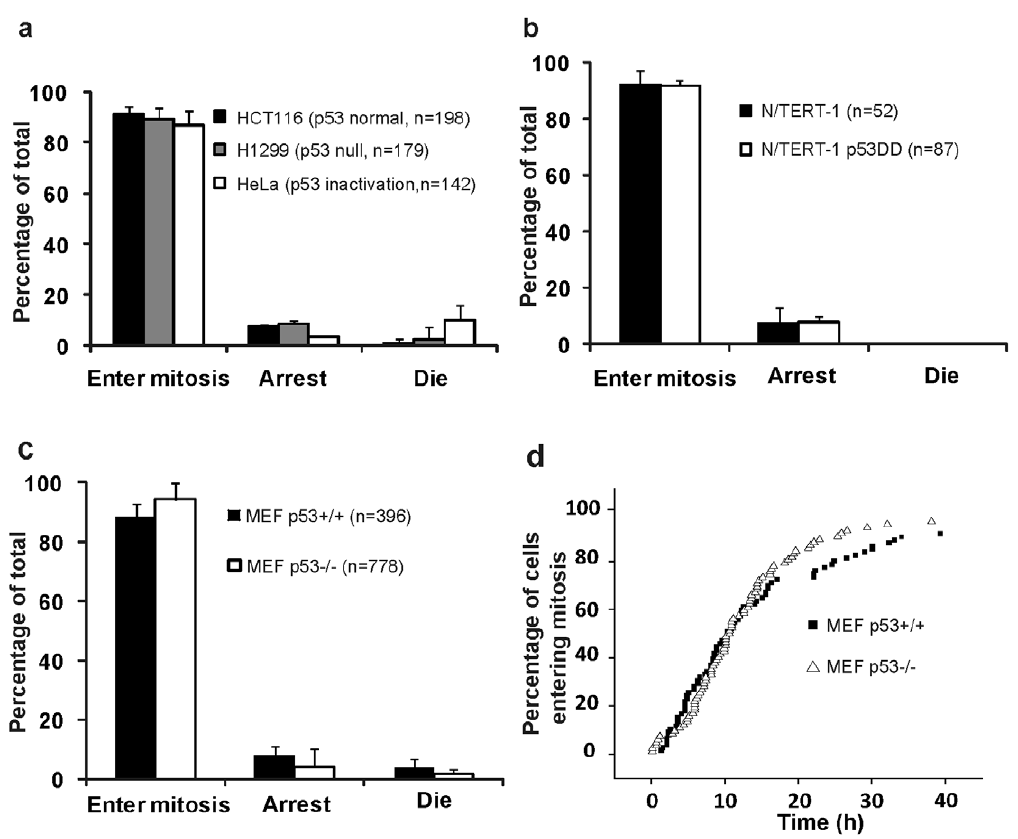
Figure 1. Effect of p53 on the fates of tetraploid cells. Cells were treated with Cyto-B to obtain tetraploid cells. After washing, cells were cultured in drug-free culture medium, and then tracked by live cell imaging. (A, B, C) Fates of tetraploid cells were detected by live cell imaging of cells with different p53 status in 3 (A), 2 (B), 5 (C) independent experiments. n, the number of cells analyzed. ( D) p53 could not delay mitosis of tetraploid MEFs. Representative time course of entering mitosis of p53 + / + and p53 -/- tetraploid cells from one experiment are shown.